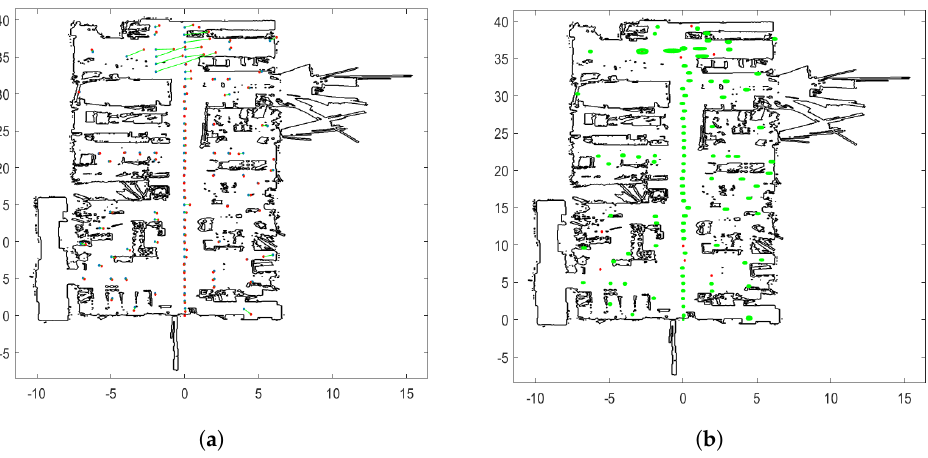
Figure A1. Static case results for Pozyx at 2m altitude. ( a ) Estimated positions from Pozyx (red) vs. ground-truth (blue) with connecting line (green). ( b ) Estimated positions from Pozyx (red) and standard deviation ellipsoids